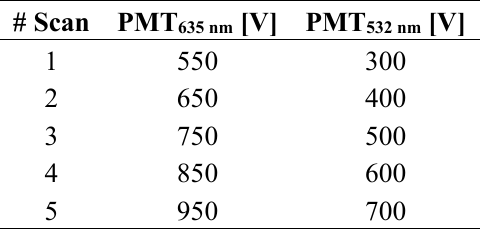
Table 2. PMT settings of validation